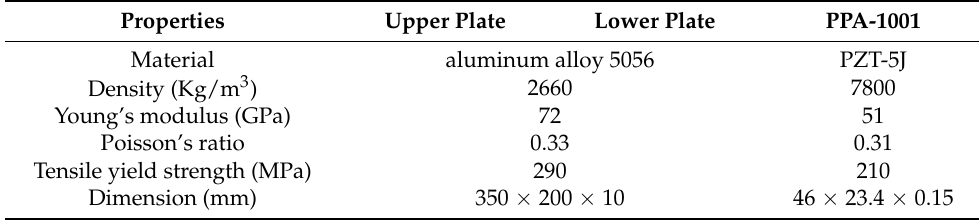
Table 1. Properties of the plates and the piezoelectric beams.